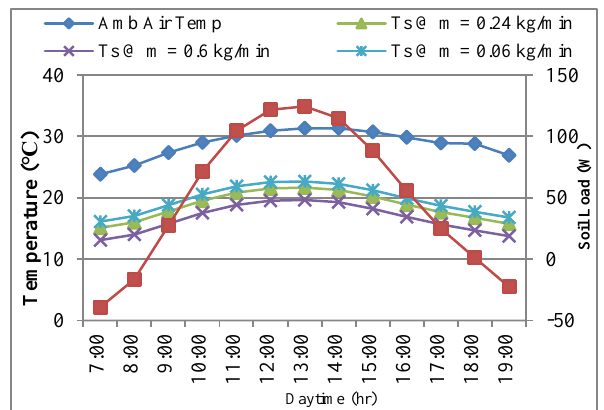
Figure 8: Modelled soil cooling profile during